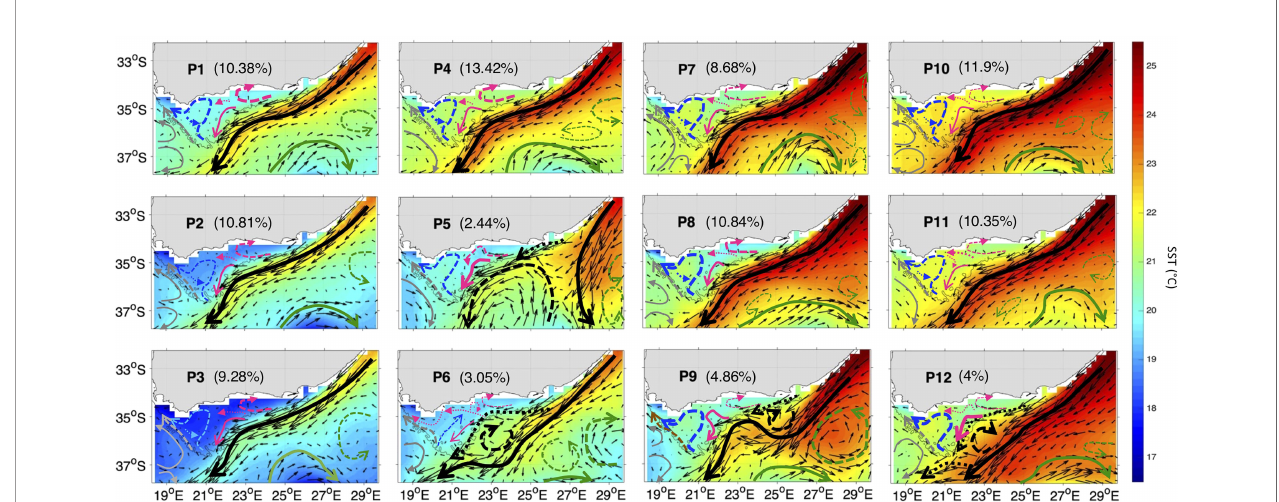
FIGURE 3 | The 12 characteristic SST (in °C) and surface currents patterns (P1 to P12) over the Agulhas area of interest (orange box, Figure 1 ) during Nov-Mar 97- 20 as derived from the 3x4 SOM. The current vectors (thin black arrows) are mapped every 2 grid points. The stronger the currents the longer are the vectors. A schematic of the currents ’ direction and speed during Nov-Mar 97-20 for 12 SOM patterns (P1 to P12) is superimposed. The black arrows represent the main AC and its associated meanders. The green (grey) arrows designate the main circulation southeast (southwest) off the Bank. The blue (pink) arrows indicate the circulation on west (east and central) Bank. The stronger the currents the thicker are the arrows. The percentages between parentheses represent the frequency of occurrence of each pattern. The 200m isobath marking the continental shelf is highlighted with a grey solid